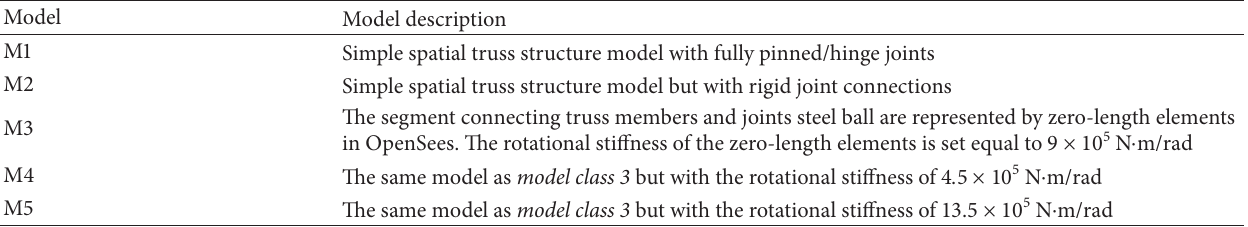
Table 3: Five competing model classes used for damage identification.